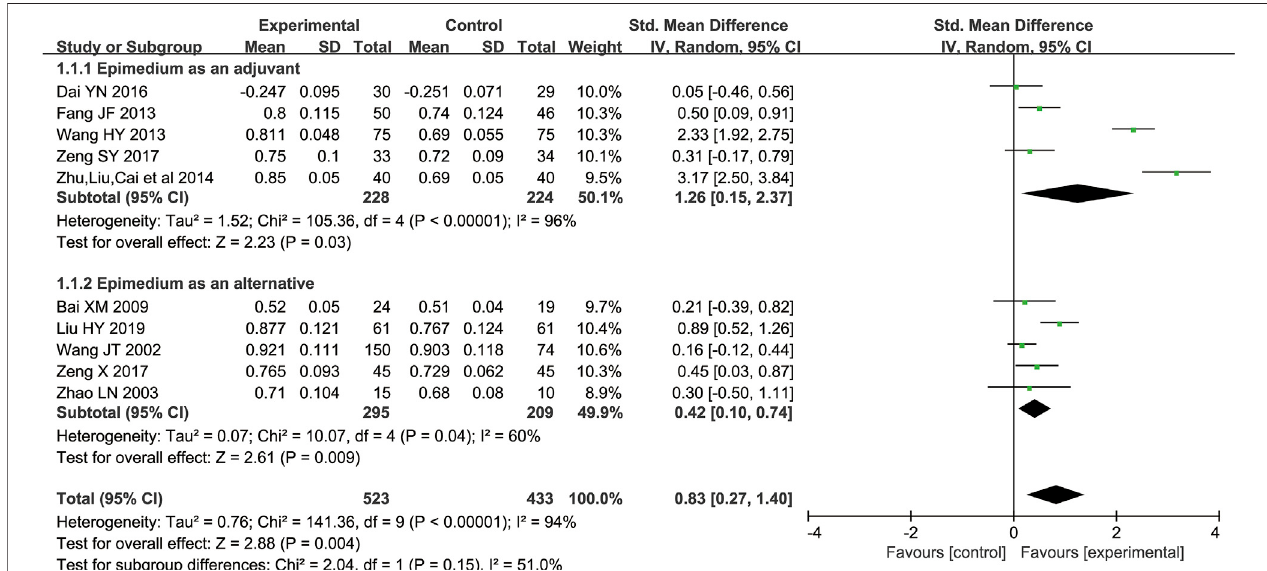
FIGURE 3 | Meta-analysis results of the effect of Epimedium vs conventional pharmacotherapy on bone mineral density.